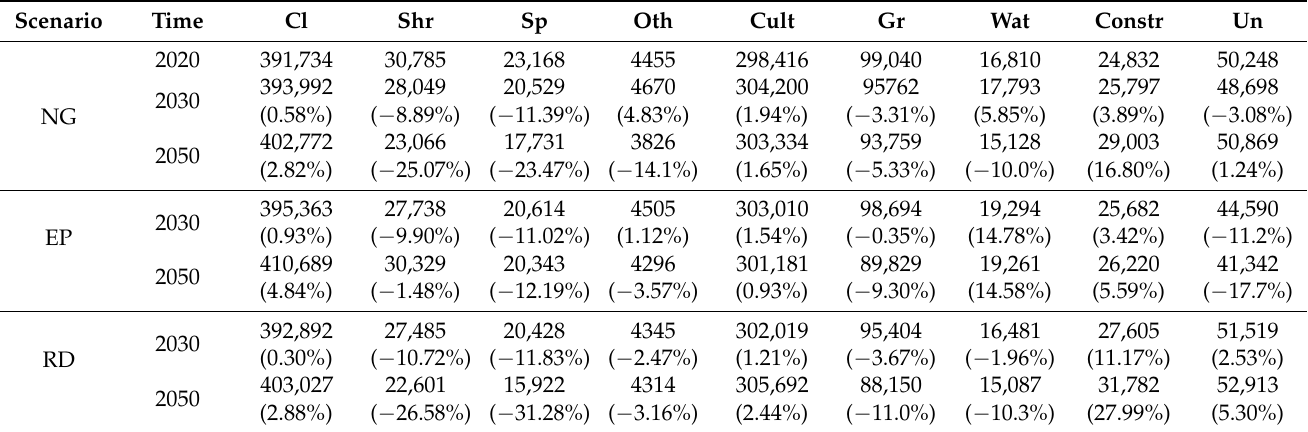
Table 5. Area setting of future scenarios and their changes in 2020 (km 2 ,